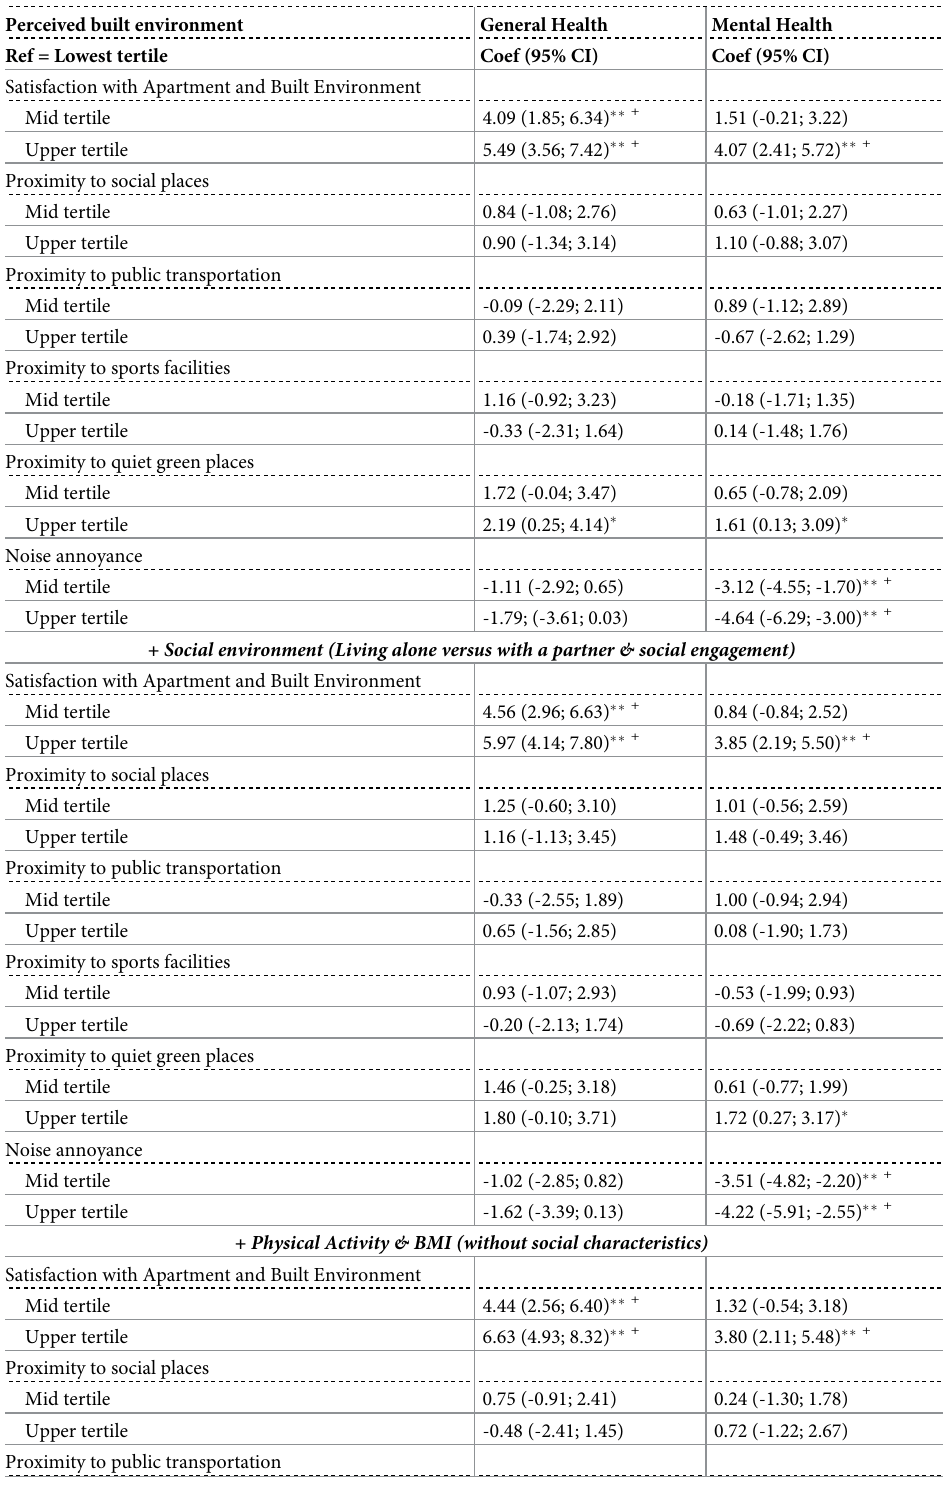
Table 2. Alteration in associations of variables defining the perceived built environment with health-related qual- ity of life by adjustment of social environment variables, physical activity and